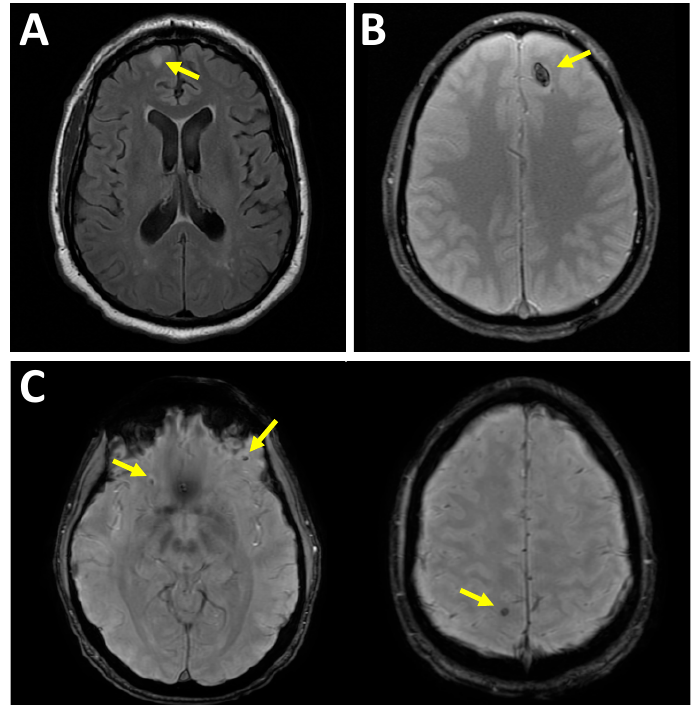
Figure 2. Intra-axial injury patterns. ( A ) Nonhemorrhagic brain surface contusion. Sixty-six-year-old male fell and hit head on concrete with subsequent loss of consciousness. Axial T2-weighted fluid-attenuated inversion recovery (FLAIR) image demonstrates focal increased signal within the right frontal lobe cortex. ( B ) Hemorrhagic brain contusion. Twenty-four-year-old male who fell and hit his head after playing basketball with subsequent loss of consciousness. Axial T2*-weighted gradient echo (GRE) image demonstrates focal region of hypointense signal in the left front lobe. ( C ) Diffuse axonal injury. Forty-year-old male after falling from multiple flights of stairs. Two axial T2* susceptibility-weighted imaging (SWI) images demonstrate multiple foci of hypointensity consistent with punctate hemorrhage at the gray-white junctions. This is a consequence of shearing forces.